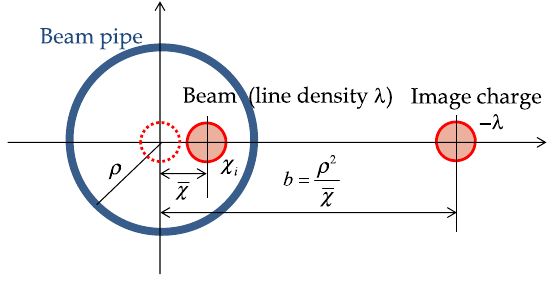
FIG. 18. Schematic diagram of the image-charge effect. position oscillation is excited by some external force such as that considered herein, this quadrupole force acts to shake the beam envelope at twice the frequency of the coherent position oscillation. That is, it leads to a second- order stopband at the corresponding incoherent betatron tune. The frequency of the coherent position oscillation observed in Fig. 16 is 100 kHz, which corresponds to 0.2